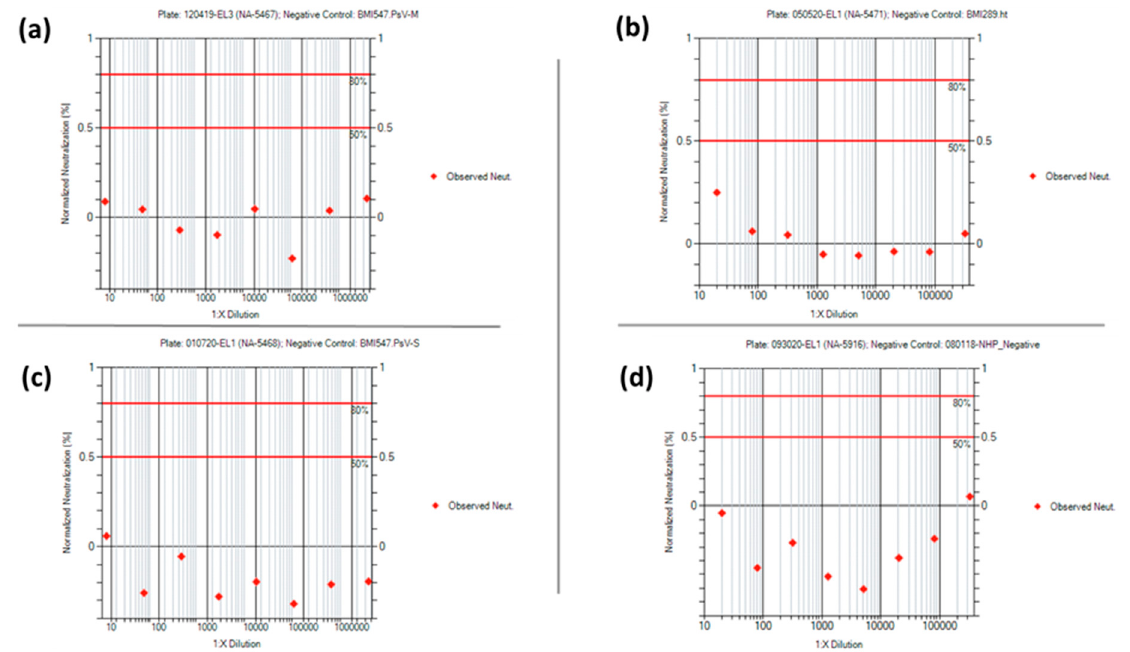
Figure 10. PsVNANeutralization Data from Negative Controls. ( a ) MARV and human; ( b ) MARV and NHP; ( c ) SUDV and human; ( d ) SUDV and NHP. The negative control indicated in the SUDV and NHP panel, 080118-NHP_Negative, is a subaliquot of BMI300.